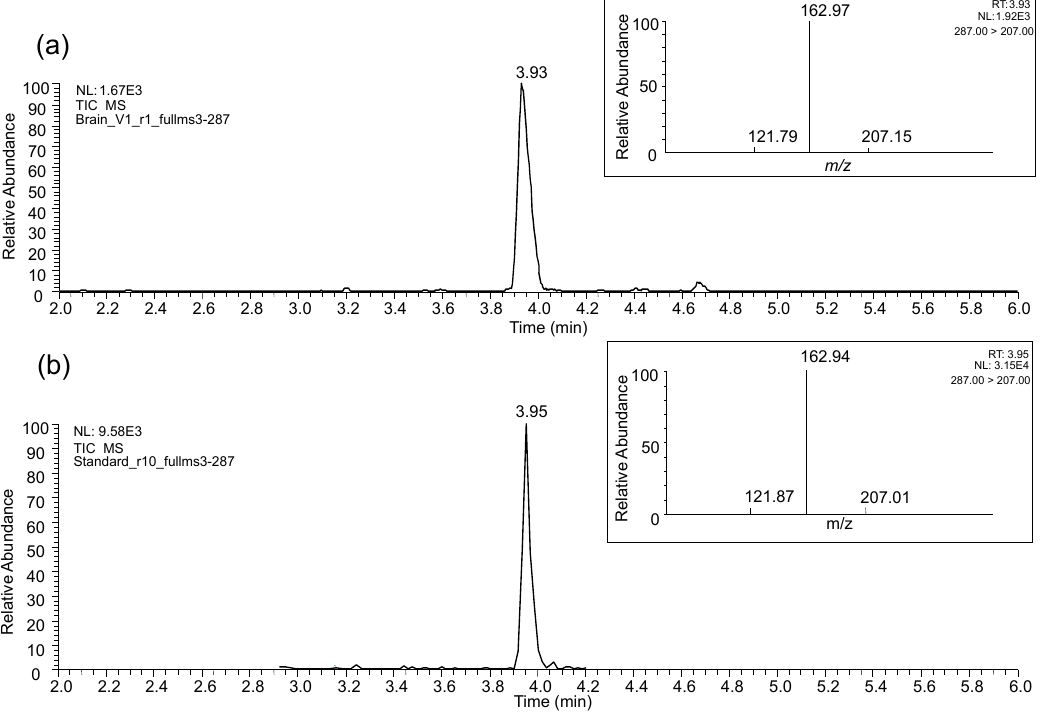
Figure 5. LC-MS profile 5-(hydroxyphenyl)- γ -valerolactone-sulfate (3’,4’ isomer) in a rat brain extract ( a ) and 5-(4’-hydroxyphenyl)- γ -valerolactone-3’-sulfate as reference standard ( b ). In the rectangular insets, the MS 3 ion spectrum of 5-(hydroxyphenyl)- γ -valerolactone-sulfate ( a ) and the reference compound ( b ).